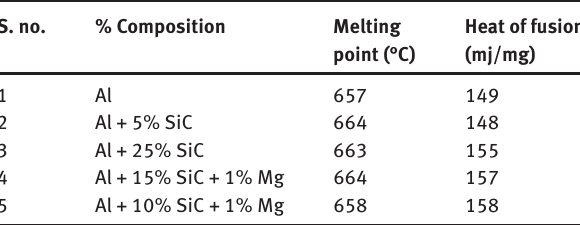
Table 2: Melting point and heat of fusion of various composition of composite S.